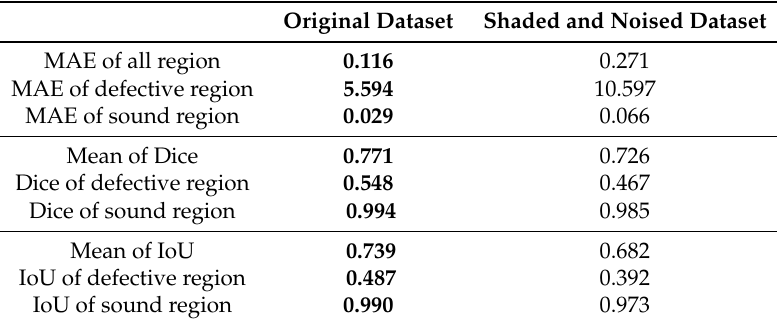
Table 6. Results with the change of illumination and noise.